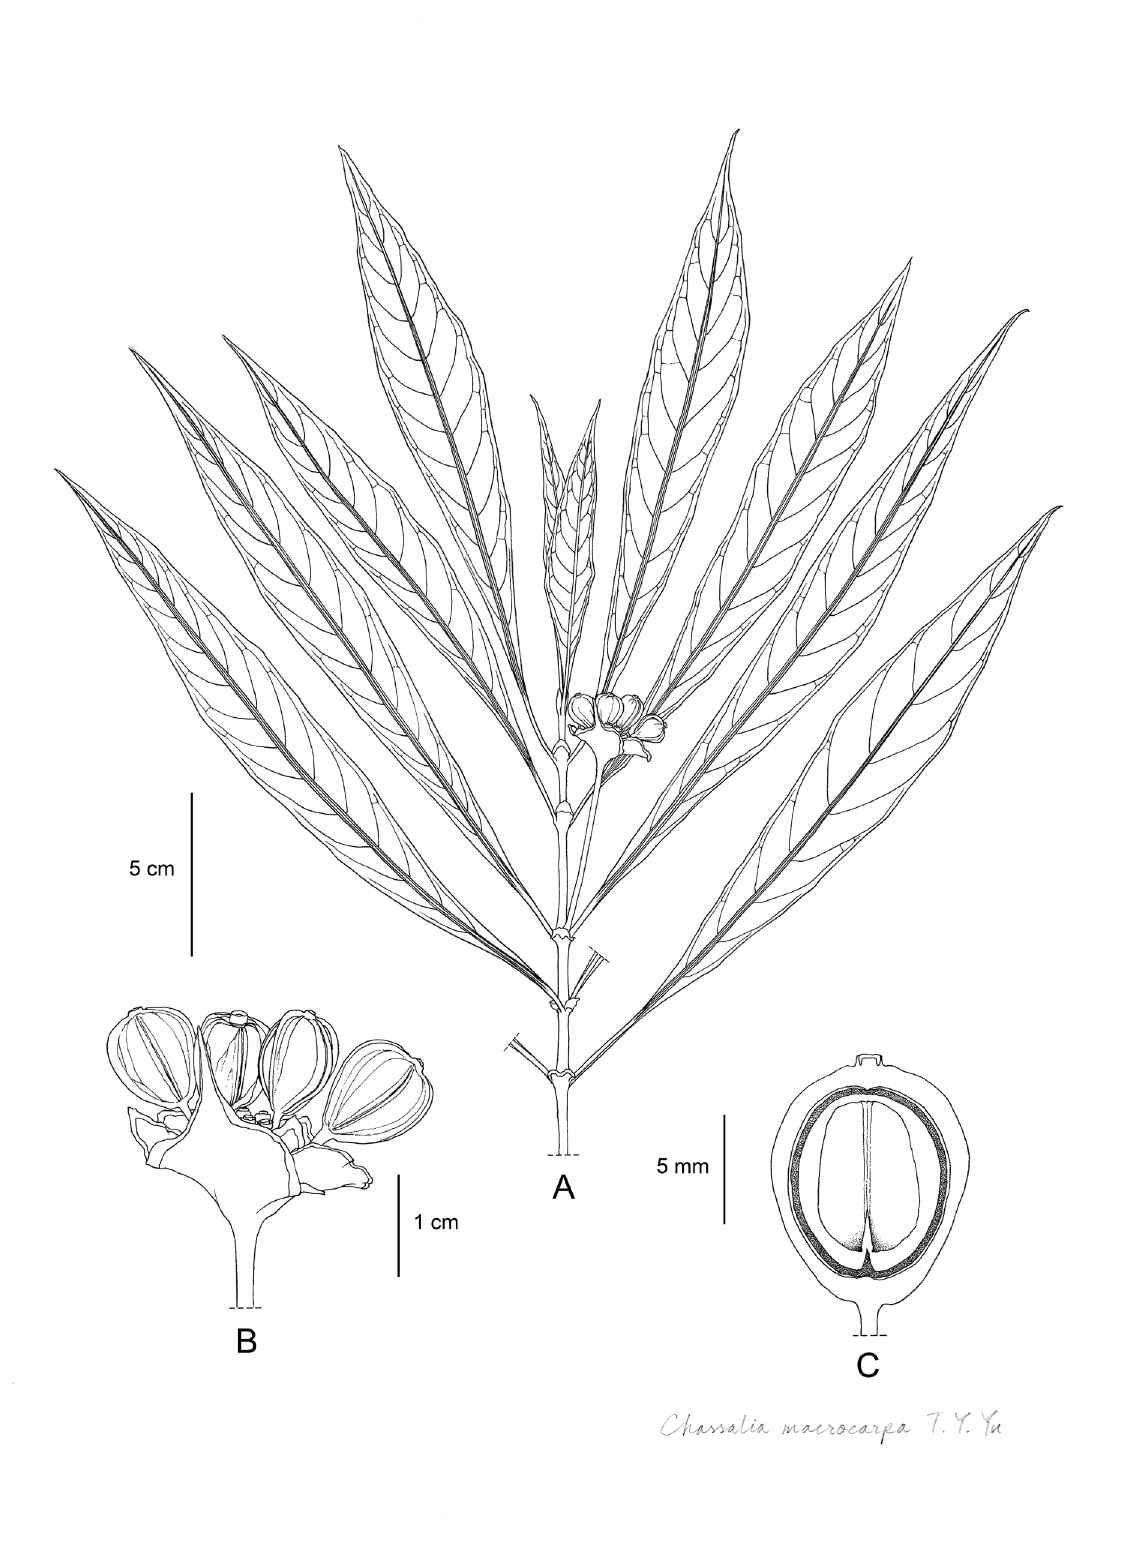
Fig. 22. Chassalia macrocarpa T.Y.Yu sp. nov. A . Flowering shoot. B . Infructescence showing dry fruit. C . Pyrene ventral surface. From Bernard Lee Meng Hock S 54027 . Drawn by T.Y.